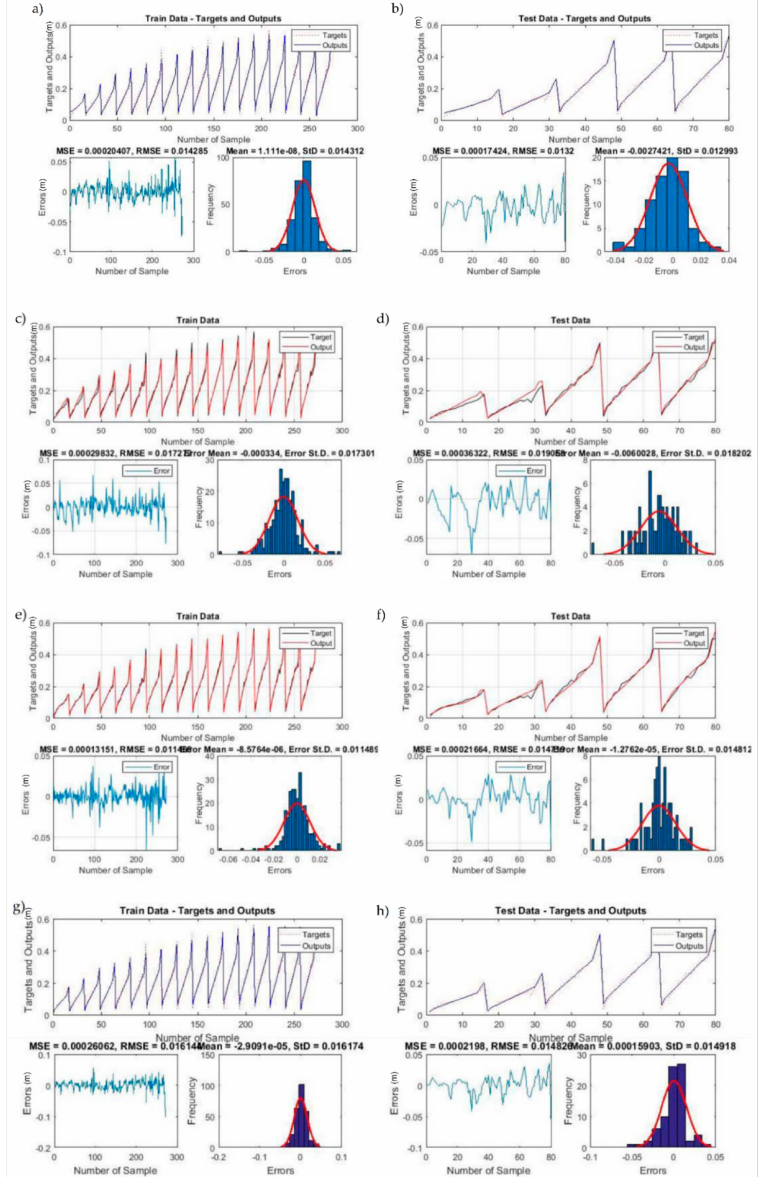
Figure 11. As in Figure 9 for y m . ANFIS Model ( a ) targets and outputs, RMSE, MSE values and frequency vs. errors graphs for train data set ( b ) targets and outputs, RMSE, MSE values and frequency vs. errors graphs for test data set. ANFIS-GA: ( c ) targets and outputs, RMSE, MSE values and frequency vs. errors graphs for train data set ( d ) targets and outputs, RMSE, MSE values, and frequency vs. errors graphs for test data set. ANFIS-PSO: ( e ) targets and outputs, RMSE, MSE values and frequency vs. errors for train data set ( f ) targets and outputs, RMSE, MSE values, and frequency vs. errors for test data set. ANFIS-FFA: ( g ) targets and outputs, RMSE, MSE values and frequency vs. errors for train data set ( h ) targets and outputs, RMSE, MSE values, and frequency vs. errors for test data